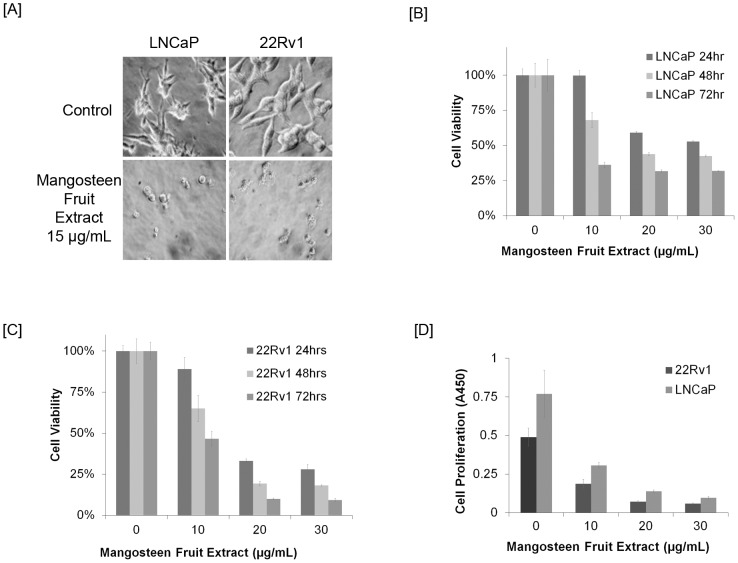
Mangosteen fruit extract (MFE) reduced viability and inhibited proliferation in vitro on two different prostate cancer cell lines, 22Rv1 and LNCaP.[A], Microscopic pictures of MFE-treated and untreated prostate cancer cells, MFE dose was indicated. [B], LNCaP cells were treated with increasing doses of MFE for 24, 48, or 72 hr, cell viability was determined by MTT assay. [C], 22Rv1 cells were treated with increasing doses of MFE for 24, 48, or 72 hr, cell viability was determined by MTT assay. [D], Both 22Rv1 and LNCaP cells were treated with increasing doses of MFE, cell proliferation was evaluated by BrdU assay. Absorbance values at 450 nm (A450) represent proliferating cell numbers. These experiments were performed in triplicate and are represented by the mean along with standard deviation.